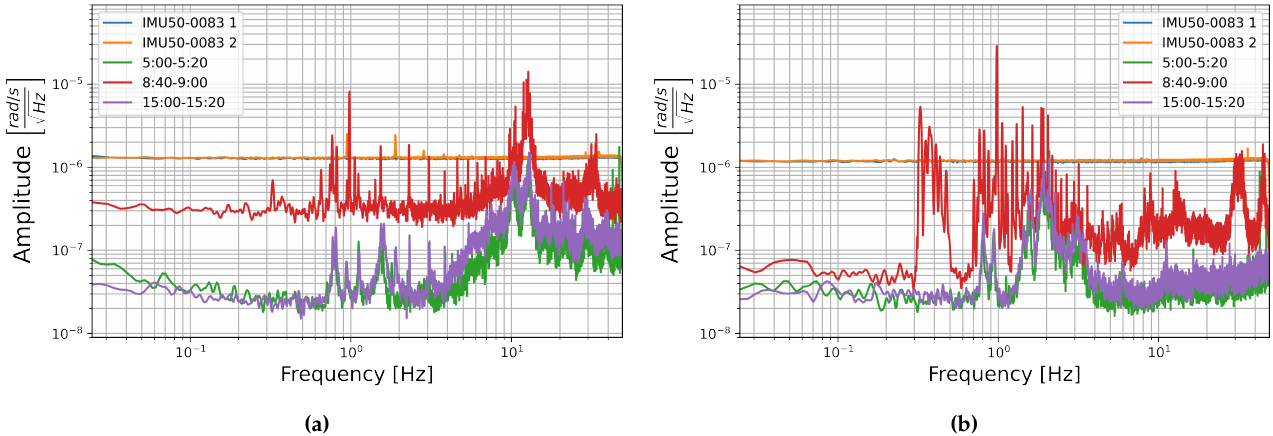
Figure 19. The square root of the PSD of self-noise recordings from sensor number 0083 (blue and orange) compared with building noise recorded in the North Tower of the Cologne Cathedral over three time spans: 5:00–5:20 (green), 8:40–9:00 (red), and 15:00–15:20 (purple) UTC time for ( a ) horizontal sensor component HJX with blueSeis-3A component HJ1 and ( b ) vertical sensor component HJZ with blueSeis-3A component HJ3.